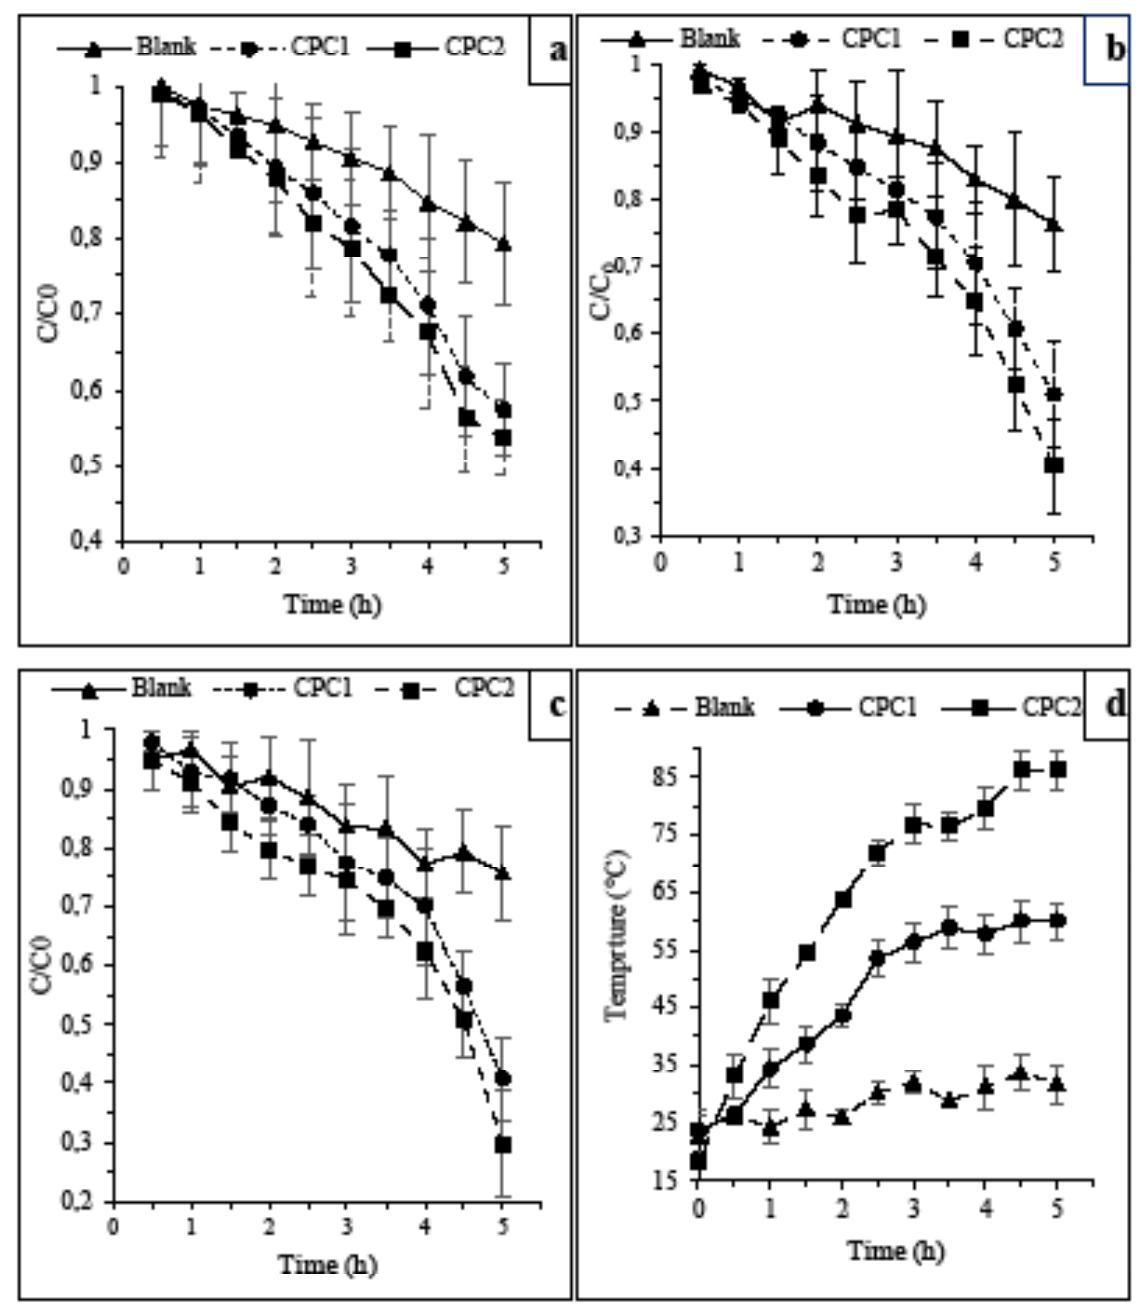
reactors in removal of Carbamazepine (Mean ± SD) at contact Time of 0.5 to Figure 5: Comparison of the Efficiency of Blank, CPC1 and CPC 2 5 hours - start time: 9:30 a.m., end time 2:30 p.m. Initial CBZ concentration = 3 mg/L (a) pH= 4± 0.1; (b) pH=7± 0.1; (c) pH= 9± 0.1 and (d) Temperature variations in these reactors